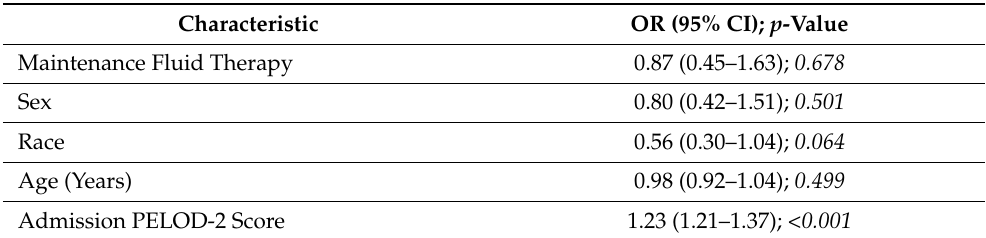
Table 2. Multivariable Logistic Regression Analysis for the Development of Acute Kidney Injury (AKI). There was no association between maintenance fluid therapy choice and AKI. (OR: odds, ratio, PELOD-2: Pediatric Logistic Organ Dysfunction).